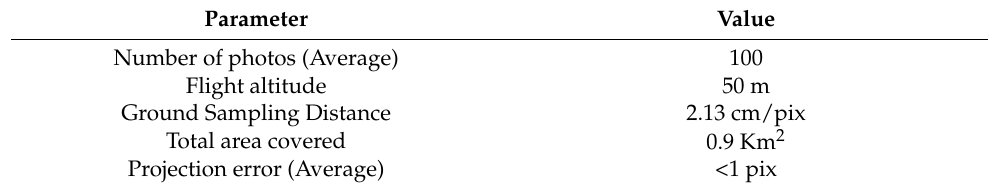
Table 1. Parameters of the flight, imagery, and terrain reconstruction referred for each